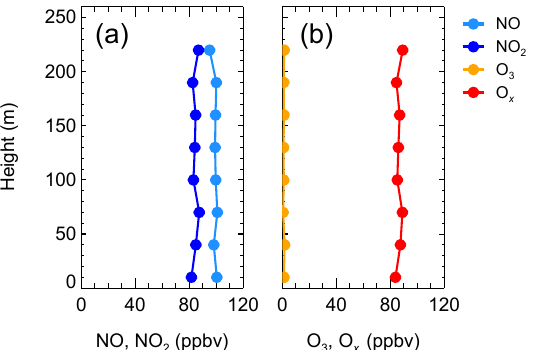
Figure 3. Vertical profiles of NO and NO 2 (a) and of O 3 and O x (b) at 20:38–21:06 on the night of 20 December 2016.